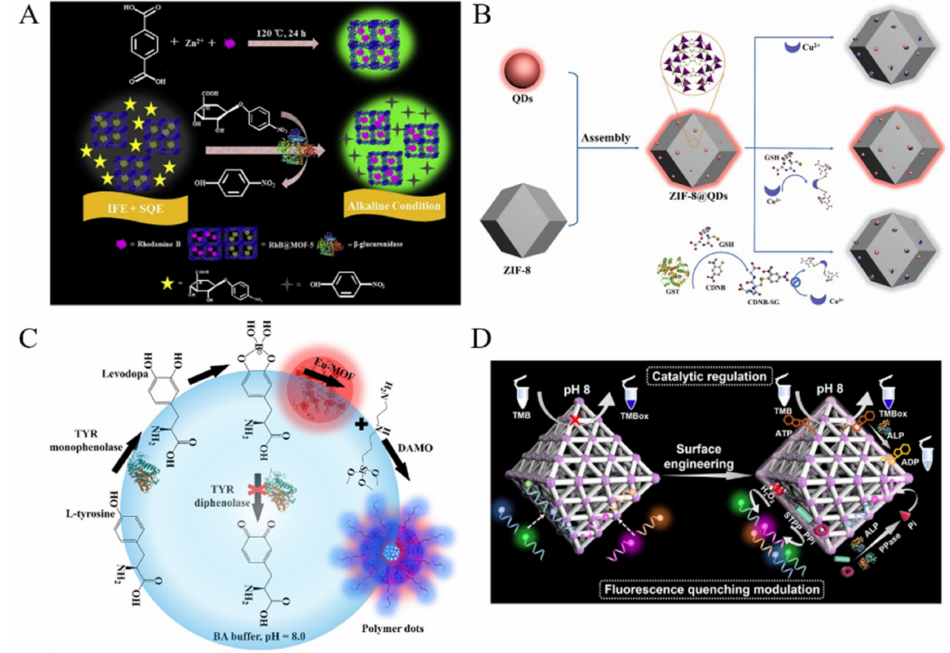
Figure 14. ( A ) Schematic illustration of the preparation procedure of RhB@MOF-5 by one-pot synthesis approach and the mechanism for β -GCU detection based on the synergistic effect of IFE and SQE. Reproduced with permission [187]. Copyright 2019, Elsevier. ( B ) Schematic illustration of the preparation of ZIF-8@QDs nanoprobe and its detection principle for GST activity. Reproduced with permission [188]. Copyright 2022, Elsevier. ( C ) Schematic illustration of fluorescence on/off dual- response sensing of TYR monophenolase activity based on Eu-MOF-assisted boric acid-levodopa polymer dots. Reproduced with permission [189]. Copyright 2022, Elsevier. ( D ) Schematic illustration of enzyme-modulated catalytic and fluorescence quenching of nanoscale MOFs. Reproduced with permission [193]. Copyright 2022, American Chemical